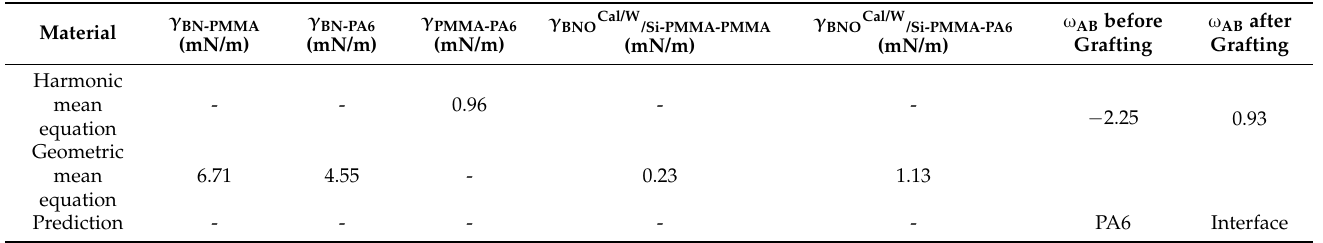
Table 4. Interfacial tensions and wetting parameter.